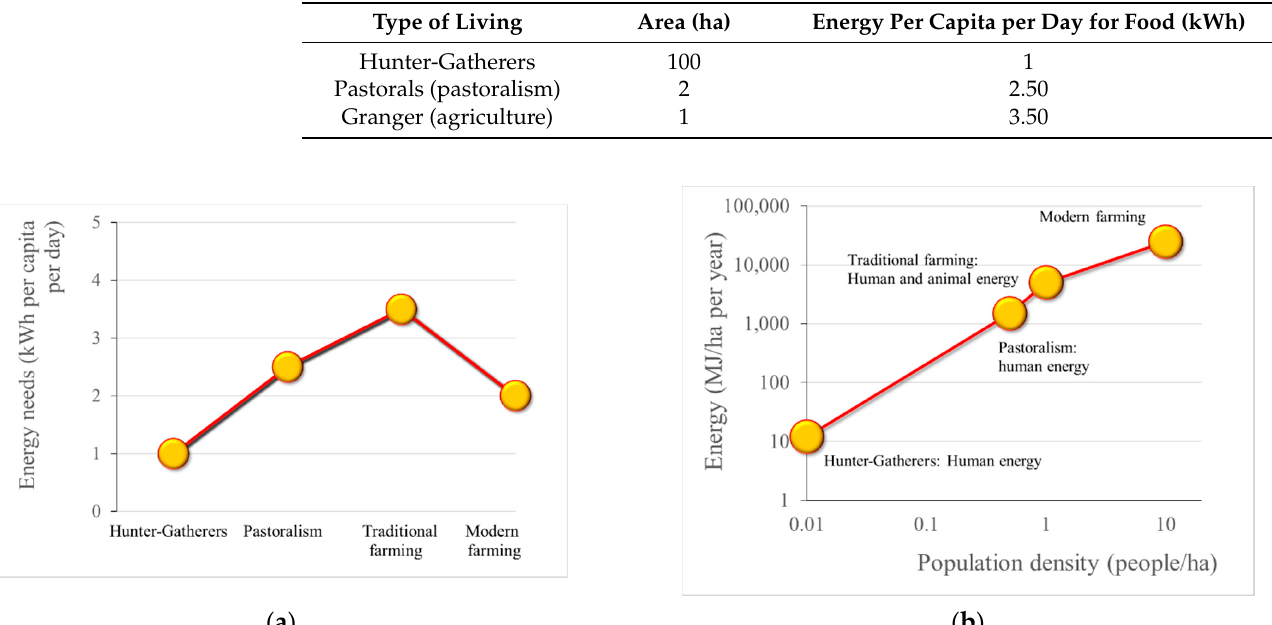
Figure 9. ( a ) Population density related to energy needs. ( b ) Energy needs per capita per day in different types of societies (diagrams present data as order of magnitude) [75,76,79–87].